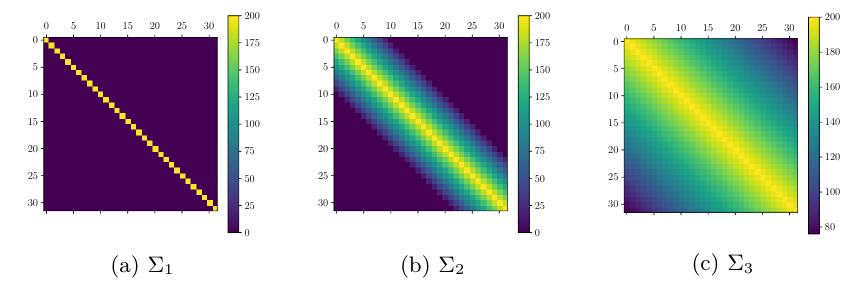
Figure 7: Covariance matrices considered in our experiments (for n l =